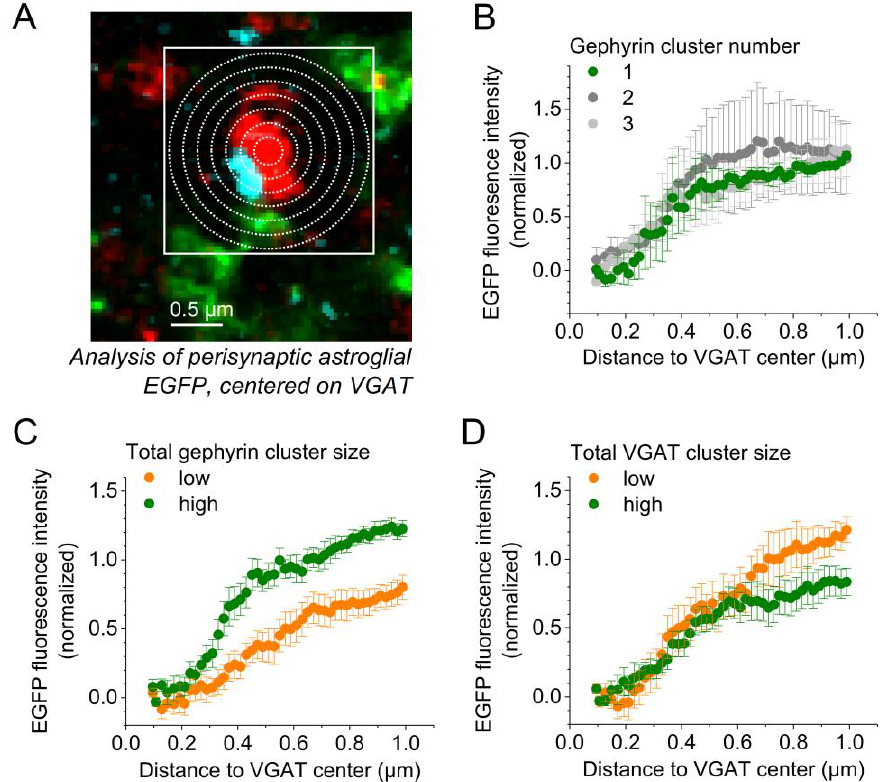
Figure 4. Synapse-specific distribution of astrocytic processes around GABAergic synapses. Ad- ditional analyses of experimental data obtained for Figure 3. ( A ) The average astrocytic EGFP fluorescence intensity (green) was determined in concentric shells with increasing diameter (white circles) centered on the center of mass of the presynaptic VGAT fluorescence (red) to quantify the astrocyte volume distribution around GABAergic synapses and its dependence on distance from the synapse (postsynaptic gephyrin, cyan). ( B ) For comparison of astrocyte volume profiles (EGFP fluorescence intensity) around GABAergic synapses with different numbers of gephyrin clusters, EGFP profiles were grouped according to the number of gephyrin clusters, averaged and normalized. Repeated measures two-way ANOVA: distance p < 0.001, interaction of distance and gephyrin cluster number p > 0.999, n = 6 average profiles from 1, 2, and 3 gephyrin clusters. Analysis of 57 synapses from 6 astrocytes from 3 independent expansion microscopy experiments (3 animals). ( C ) Comparison of astrocyte volume profiles (EGFP fluorescence intensity) around GABAergic synap- ses with small and large postsynaptic gephyrin clusters. For each astrocyte, EGFP profiles were grouped according to the gephyrin cluster fluorescence intensity (low = below the median intensity of gephyrin clusters of that astrocyte, high = above that median), averaged and normalized. Re- peated measures two-way ANOVA: distance p < 0.001, interaction of distance and high/low p < 0.001, n = 9 average profiles for high and low. Analysis of 86 synapses from 9 astrocytes from 3 independent expansion microscopy experiments (3 animals). ( D ) Comparison of astrocyte volume profiles (EGFP fluorescence intensity) around GABAergic synapses with small and large presynap- tic VGAT clusters. Analysis as in ( C ). Repeated measures two-way ANOVA: distance p < 0.001, in- teraction of distance and high/low p > 0.999, n of synapses, astrocytes, and experiments as in ( C ).